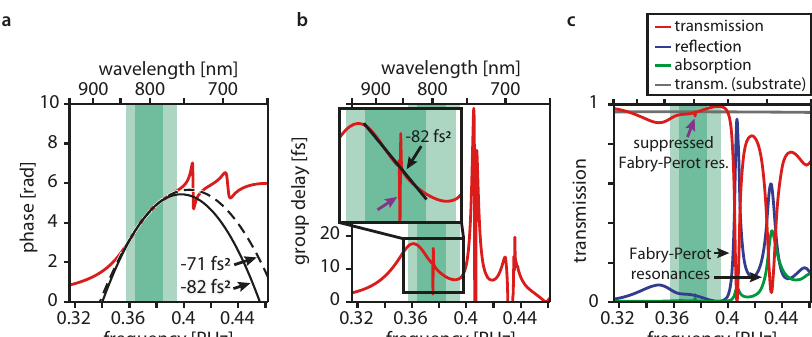
Fig. 2 Finite-difference time-domain (FDTD) modeling results for the compressor coating. a Transmission phase pro fi le (red line) predicted by FDTD simulations for the compressor design displayed in Fig. 1b. The dashed black line is a parabolic fi t to the phase pro fi le within the full working range (light green area) and the solid black line is a parabolic fi t to the phase pro fi le within the linear working range (dark green area). The fi ts are labeled with the curvatures of the parabolae, which is the group delay dispersion. The downward curvature of the parabolae indicates anomalous dispersion. b Simulated transmission group delay pro fi le (red line), i.e., the derivative of the transmission phase pro fi le. The inset shows the magni fi ed working ranges. The black line represents a linear fi t to the linear working range (dark green area) and is labeled by its group delay dispersion. The downward slope indicates anomalous dispersion. In the full working range (light green region), the group delay deviates by <2 fs from a linear pro fi le. A narrowband (<1 nm) residual signature of the suppressed Fabry-Perot resonance in the working range is marked with a purple arrow in b and c (see text and Supplementary Figs. 1 and 2). c Simulated transmission (red line), re fl ection (blue line), and linear absorption characteristics (green line) of a compressor-coated silicon dioxide substrate surface. Two-photon absorption 41 in the compressor coating remains below 1% for incident intensities beyond 50 GW cm − 2 . The transmission of the uncoated surface is plotted as a reference (gray line). The working ranges (green areas) are marked as a guide to the